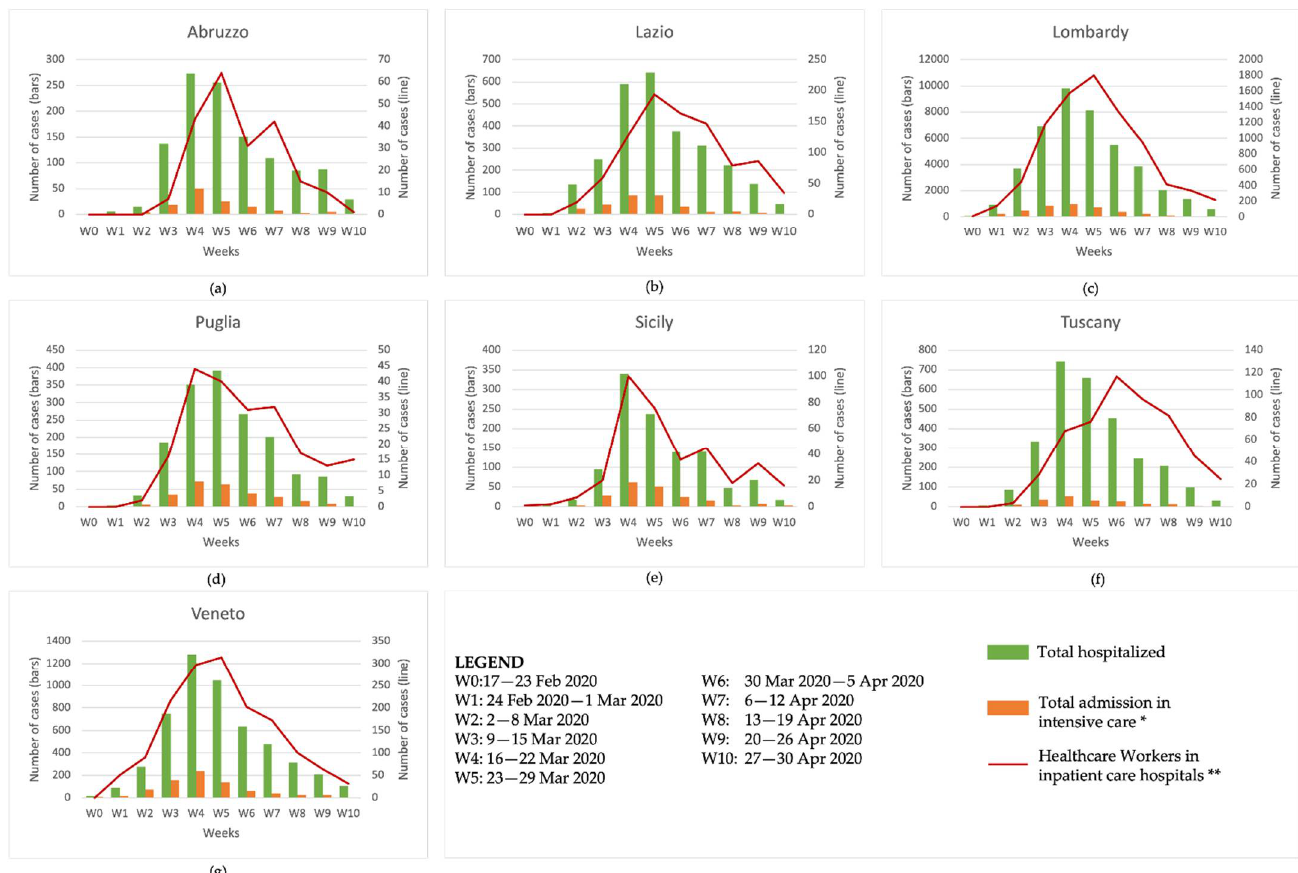
Figure 2. The number of total hospitalizations, total admissions in intensive care and HCWs in inpatient care hospitals by week from the beginning of the pandemic until 30 April 2020 in ( a ) Abruzzo, ( b ) Lazio, ( c ) Lombardy, ( d ) Puglia, ( e ) Sicily, ( f ) Tuscany and ( g ) Veneto. (*) ISS integrated epidemiological surveillance data; (**) retrospective study INAIL-ISS data.